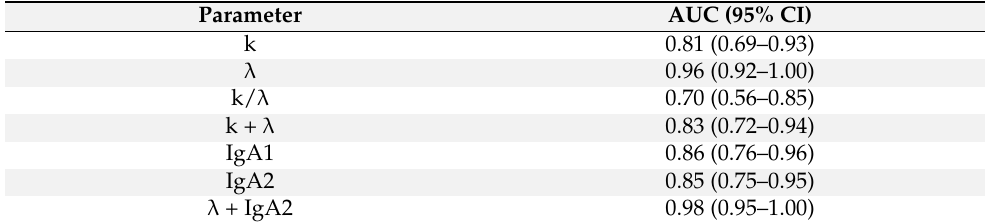
Table 3. AUC values (95% CI) for ROC curves in Figure